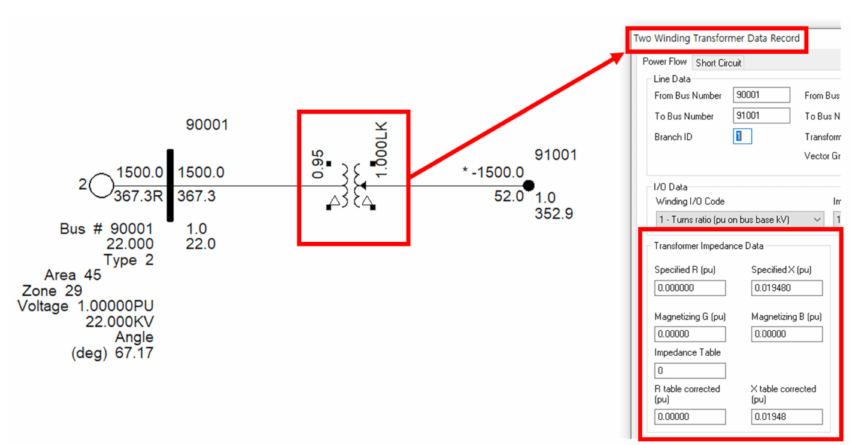
Figure A8. Internal transformer modeling based on PSS / E [26].